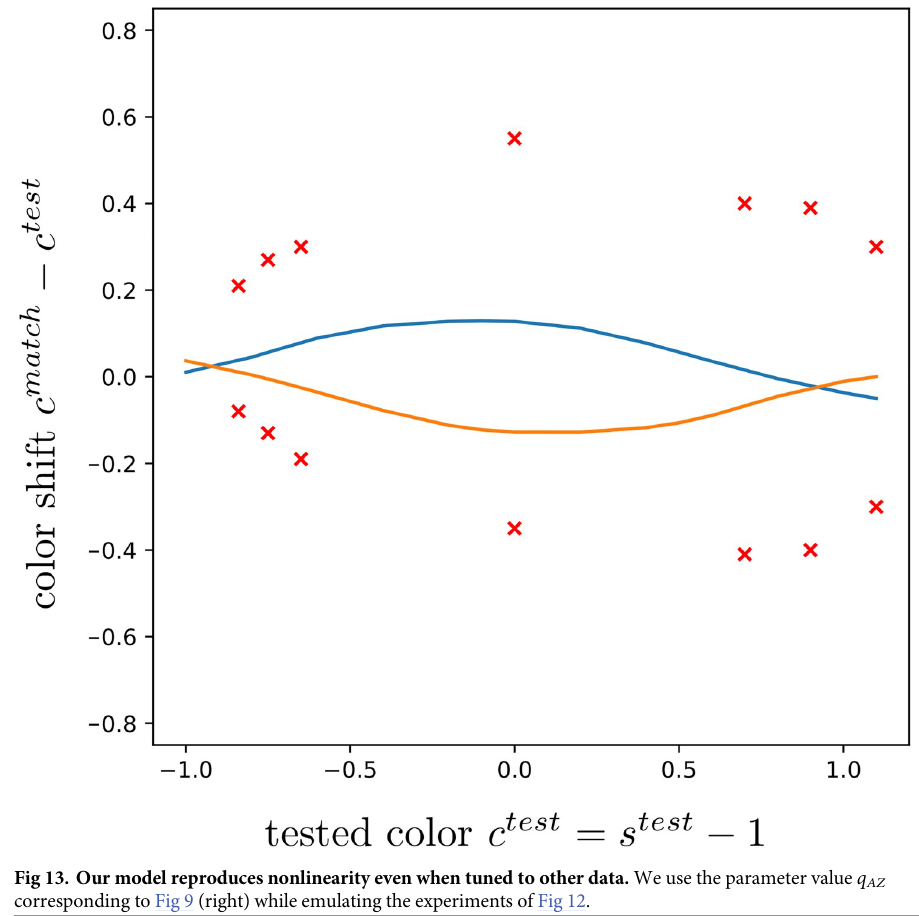
Fig 13. Our model reproduces nonlinearity even when tuned to other data. We use the parameter value q AZ corresponding to Fig 9 (right) while emulating the experiments of Fig 12.